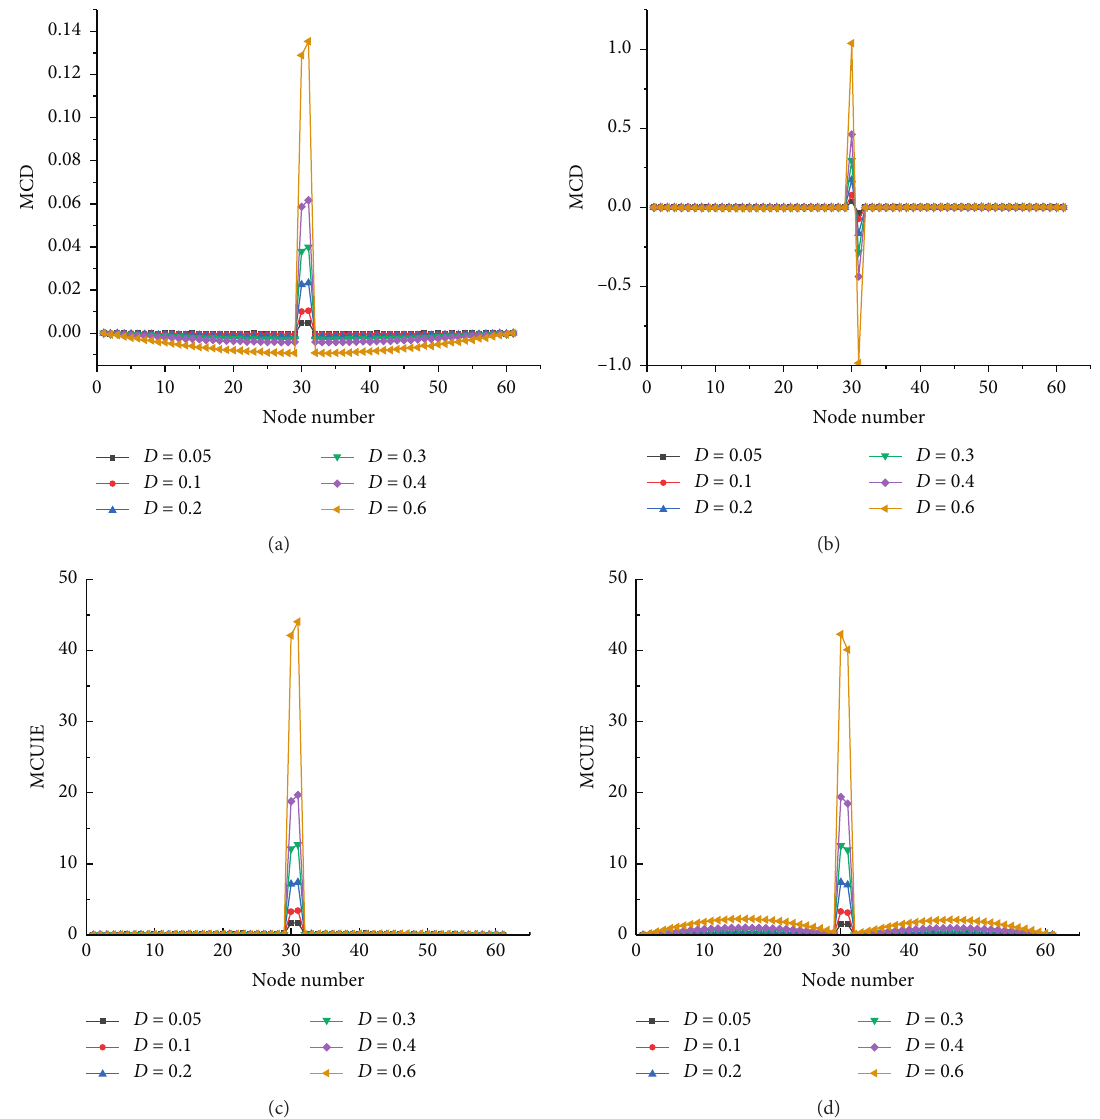
Figure 13: Damage identification results of MDC and MCUIE index of case studies 5. (a) First-order MCD. (b) Second-order MCD. (c) First-order MCUIE. (d) Second-order MCUIE.